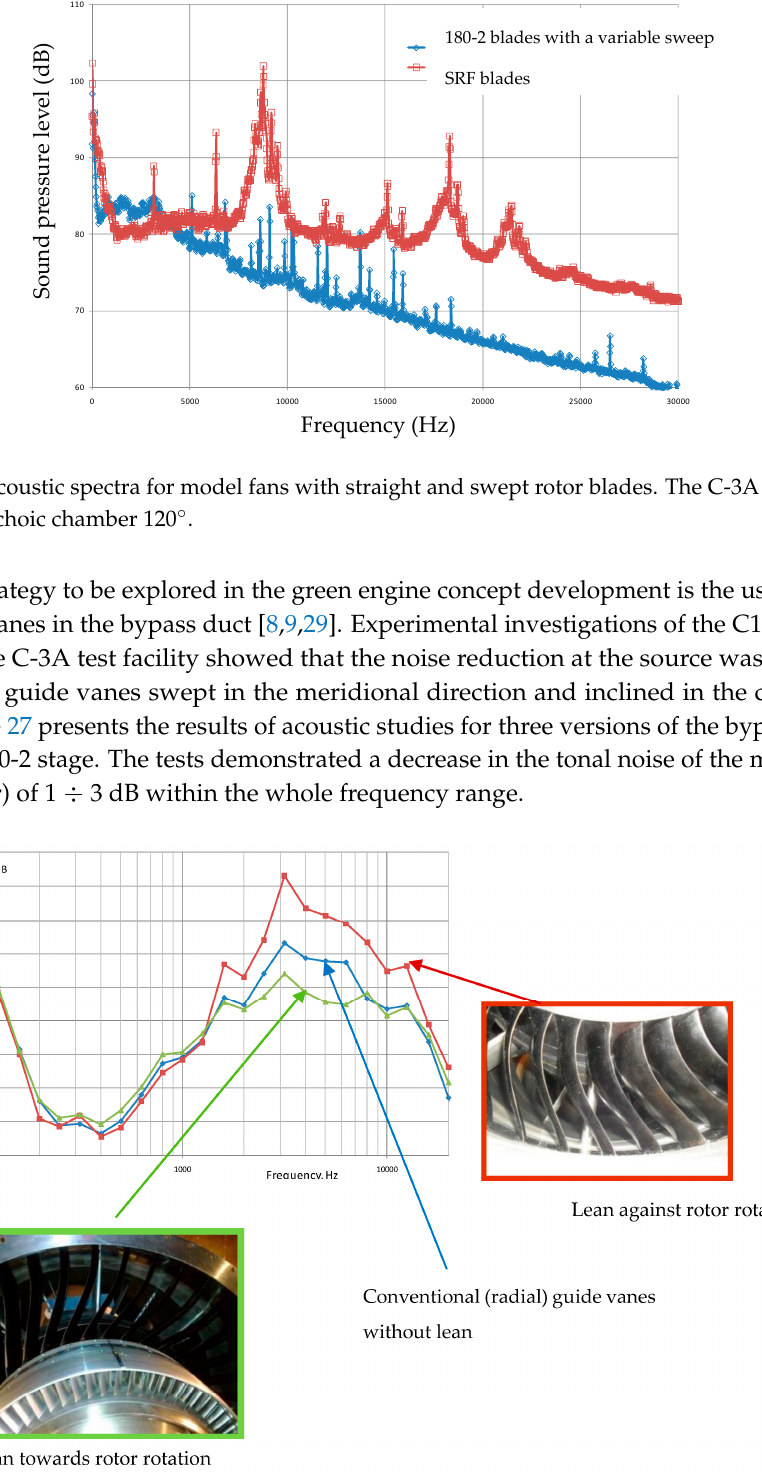
Figure 25. Single reference fan (SRF) model.